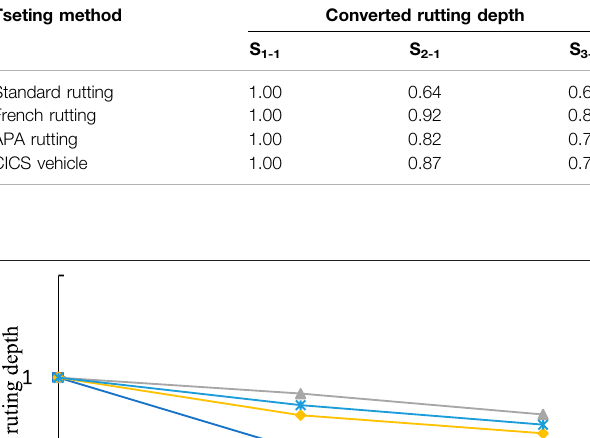
TABLE 5 | Rutting depth after standardized conversion.